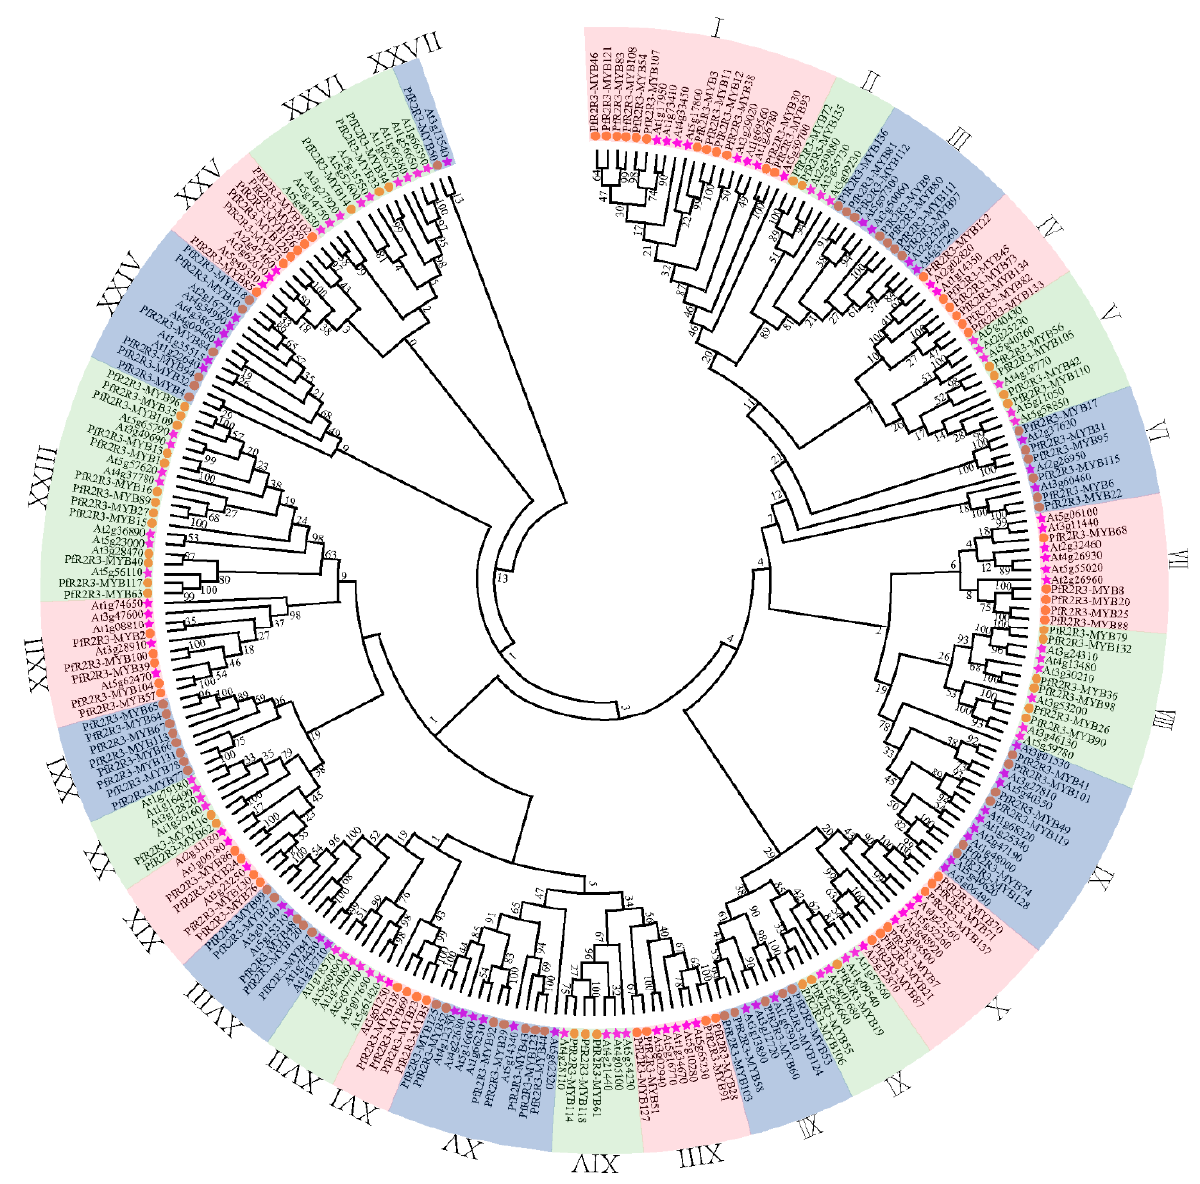
Figure 2. Phylogenetic analysis of the R2R3-MYB s proteins in P. fortunei and A. thaliana . Phylogenetic tree of R2R3-MYB family genes in P. fortunei and A. thaliana . MEGA 7.0 was used to generate the unrooted neighbor-joining tree with 1000 bootstrap replicates. The R2R3-MYB s from P. fortunei and A. thaliana were divided into 27 groups. The R2R3-MYB genes are labeled in yellow and pink for P. fortunei and A. thaliana , respectively.